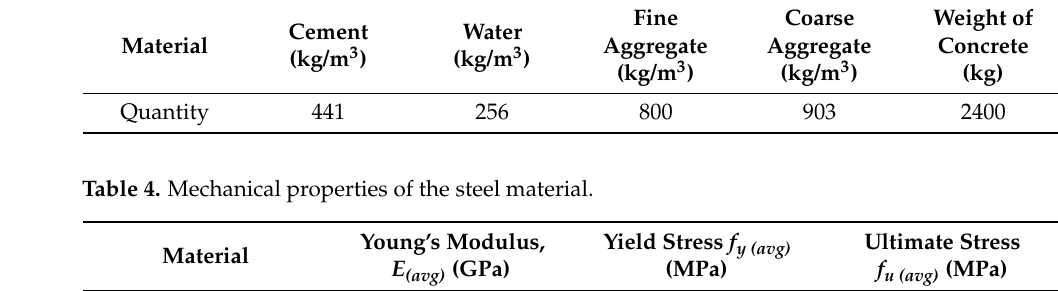
Table 3. The mix proportion of the sandwiched concrete.